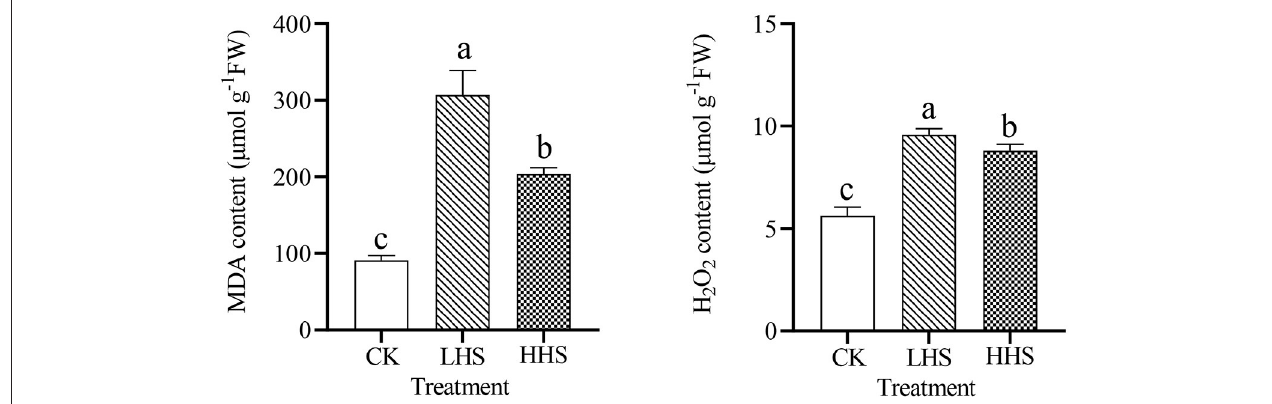
FIGURE 2 | Contents of malondialdehyde (MDA), contents of hydrogen peroxide (H 2 O 2 ) in Rhododendron simsii . leaves under CK, control (25/20 ◦ C); LHS, light heat stress (35/30 ◦ C); HHS, high heat stress (40/35 ◦ C). Each value represents the mean ± standard deviation ( n = 4). Different lowercase letters indicate the significant differences ( P < 0.05) among treatment by Duncan